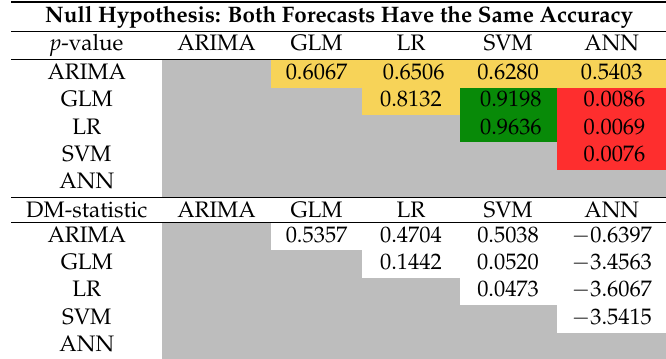
Table 4. Diebold–Mariano (DM)-test results on AAPL for all five forecasting models, carried out in pairs. Green colors represent high p -values, while red corresponds to cases where the null hypothesis is rejected due to almost zero p -values. Null Hypothesis: Both Forecasts Have the Same Accuracy p -value ARIMA GLM